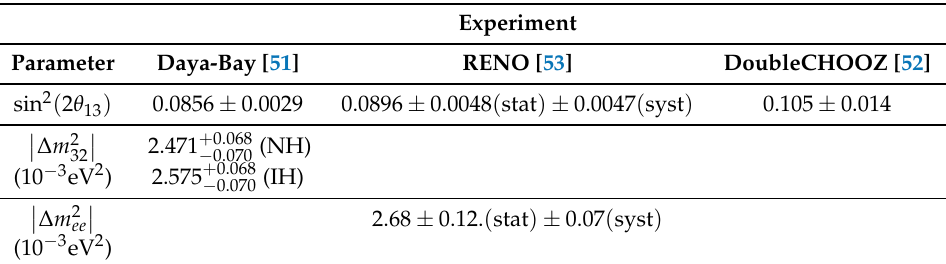
Table 2. Summary of the oscillation parameter values extracted by the analysis of the three main present SBL reactor